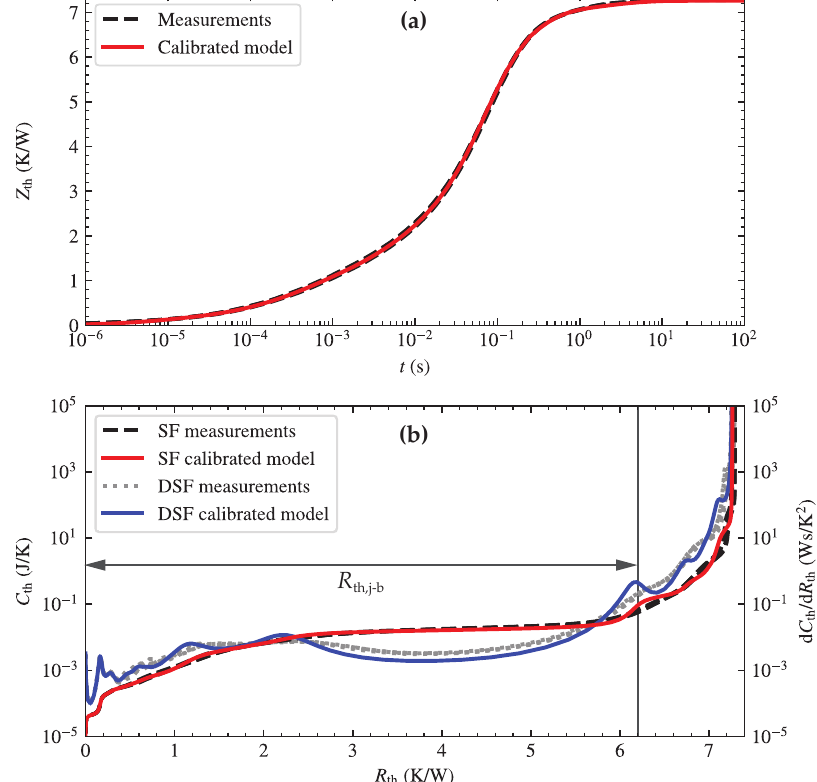
Figure 6. Thermal transient characteristics of the measured LED device and the calibrated LED detailed model: ( a ) Thermal transient impedance of the DUT and calibrated detailed model. ( b ) Structure function and differential structure function of the DUT and the calibrated detailed